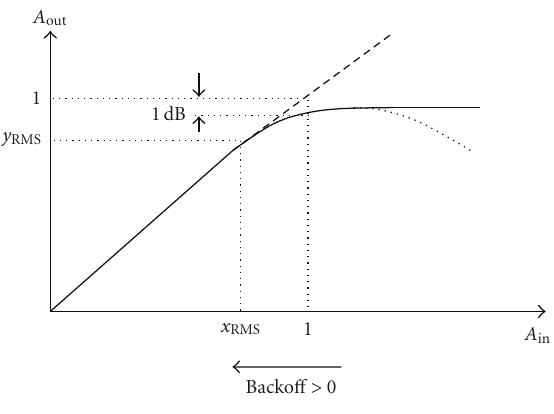
Figure 3: PA input-output power